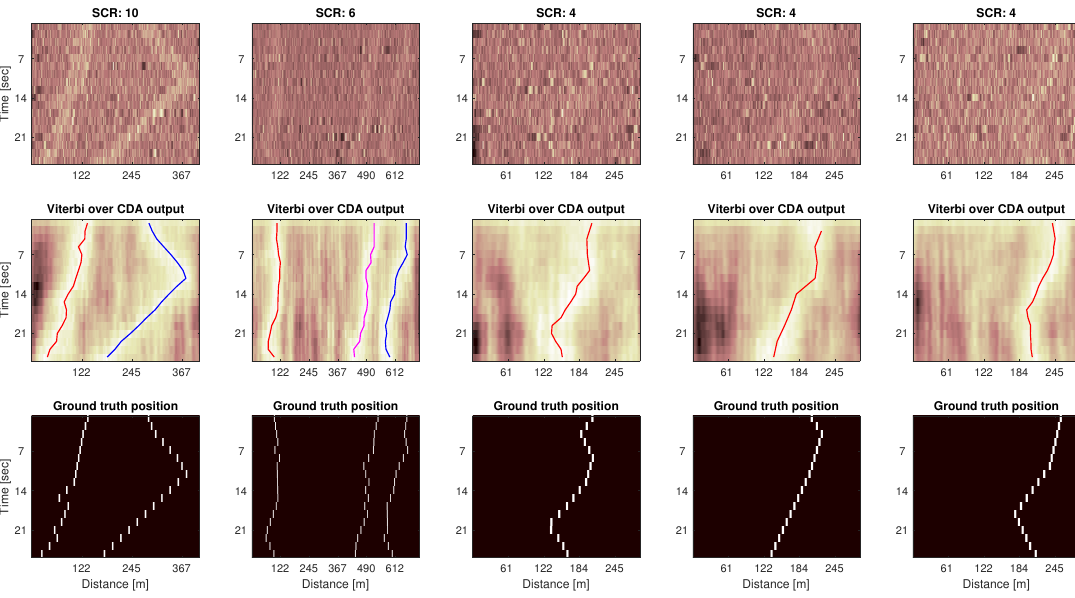
Figure 6. Tracking examples for several TD matrices featuring multiple and single moving targets, at different levels of Signal-to-Clutter ratios. The top row shows the input (noisy) images. The middle row shows the CDA (denoised) images, with the tracked path discovered by our CDA-TBD algorithm superimposed as a red curve. Bottom panels show the corresponding ground truth position of the